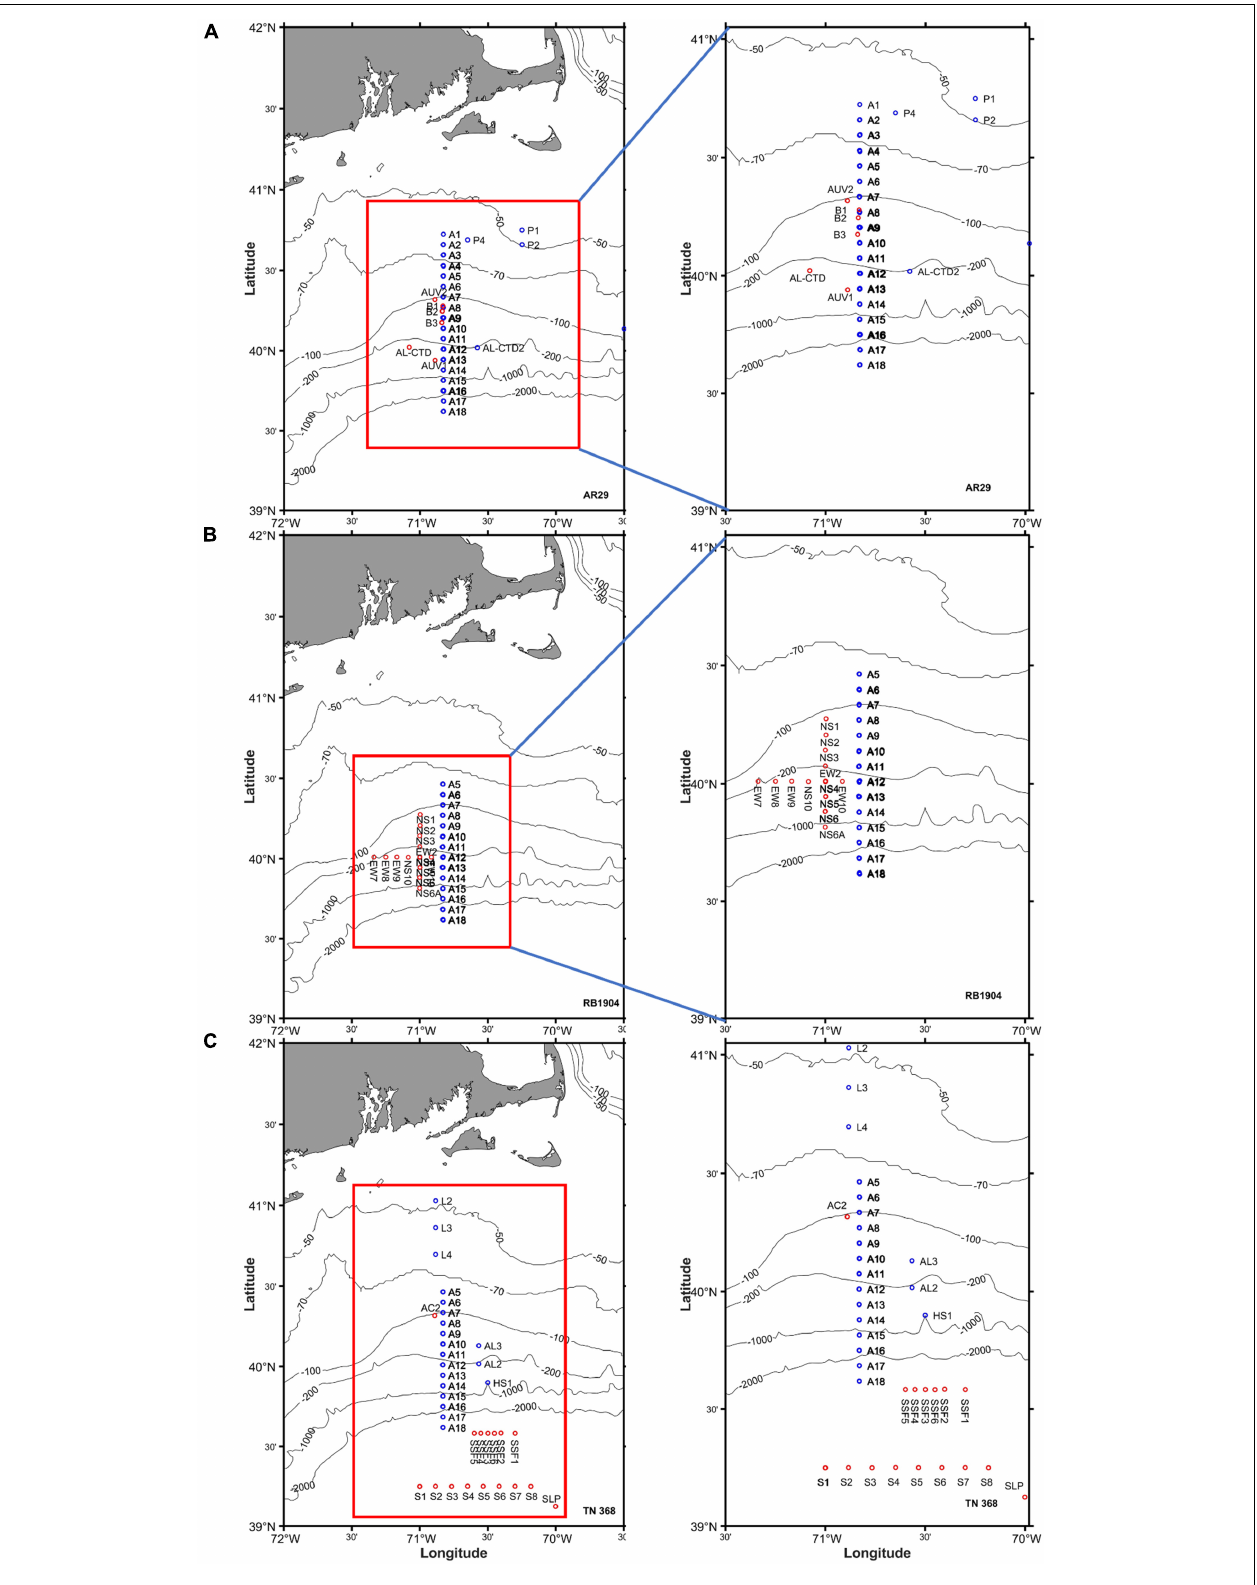
FIGURE 1 | The locations of CTD stations occupied during (A) AR29, (B) RB1904, and (C) TN368 on the continental shelf and the slope waters off New England.